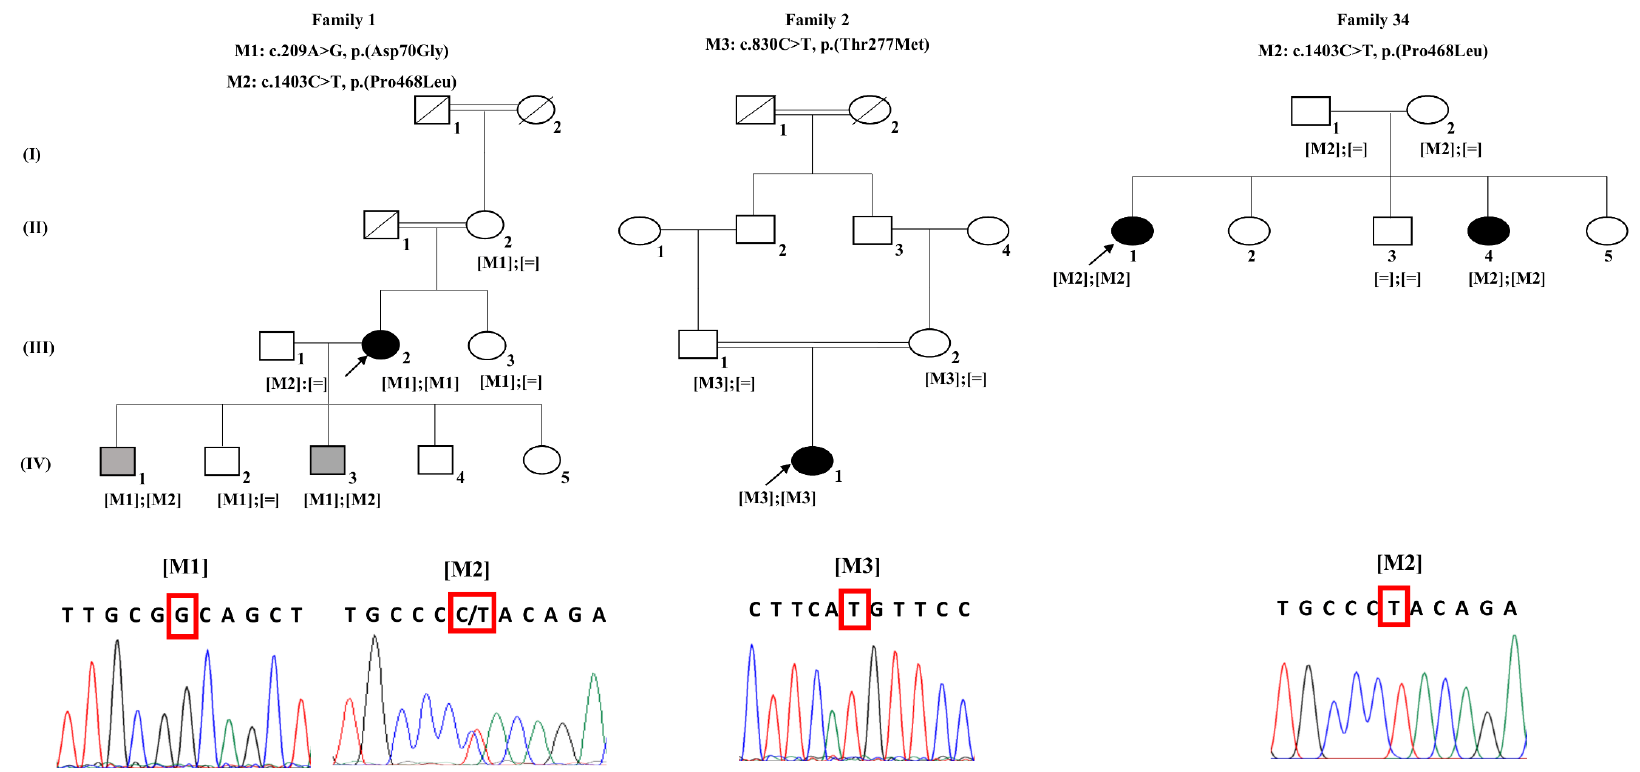
Figure 1. Pedigrees of three families diagnosed with autosomal recessive bestrophinopathy. Chromatograms for index patients were also shown: [M1] belongs to F1: III.2; [M2] in family 1 belongs to F1: IV.1; [M3] belongs to F2: IV:1; [M2] in family 34 belongs to F34: II.1. White symbols indicate unaffected patients. Black symbols indicate multifocal lesions, subretinal fluid, and intraretinal cysts (F1: III.2). Gray symbols indicate a phenotype with a single vitelliform lesion (F1: IV.1 and F1: IV.3). Square and round symbols represent males and females, respectively. The slash indicates deceased individuals. The black arrows indicate the probands (F1: III.2, F2: IV.1, F34: II.1). Double horizontal lines represent consanguineous marriages. M signifies mutation.